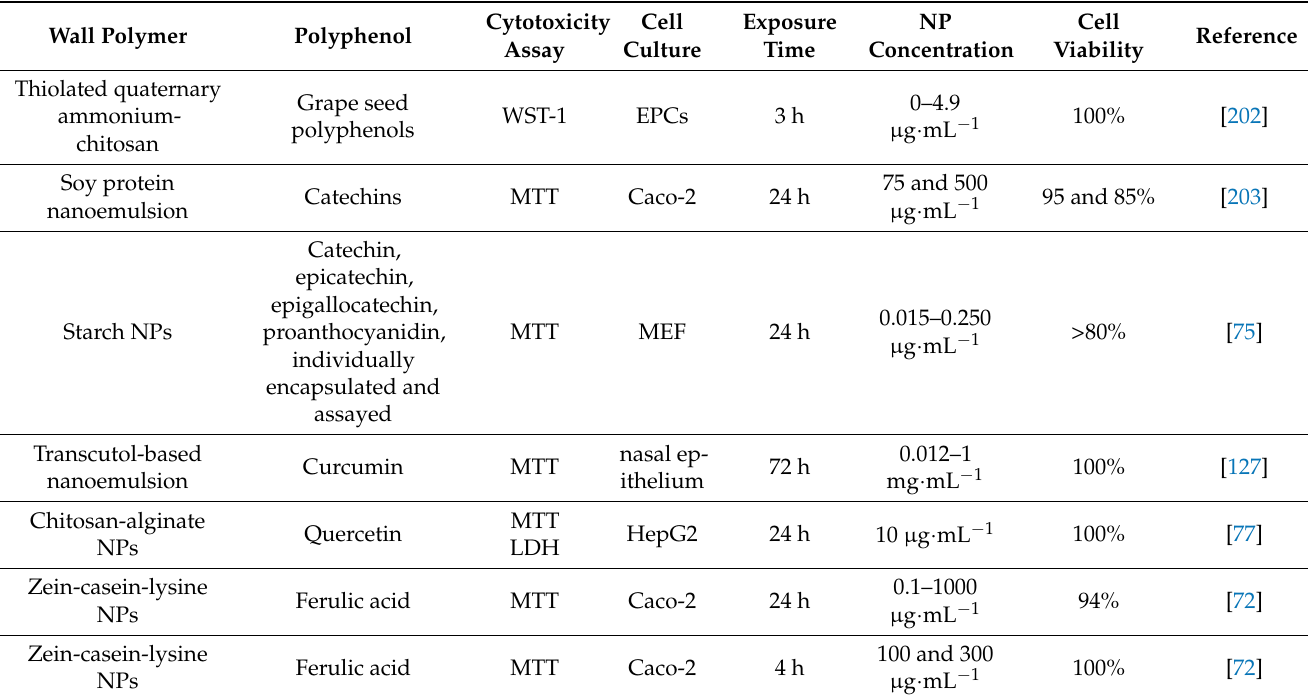
Table 1. Cytotoxicity testing of food-grade NPs in healthy cultured